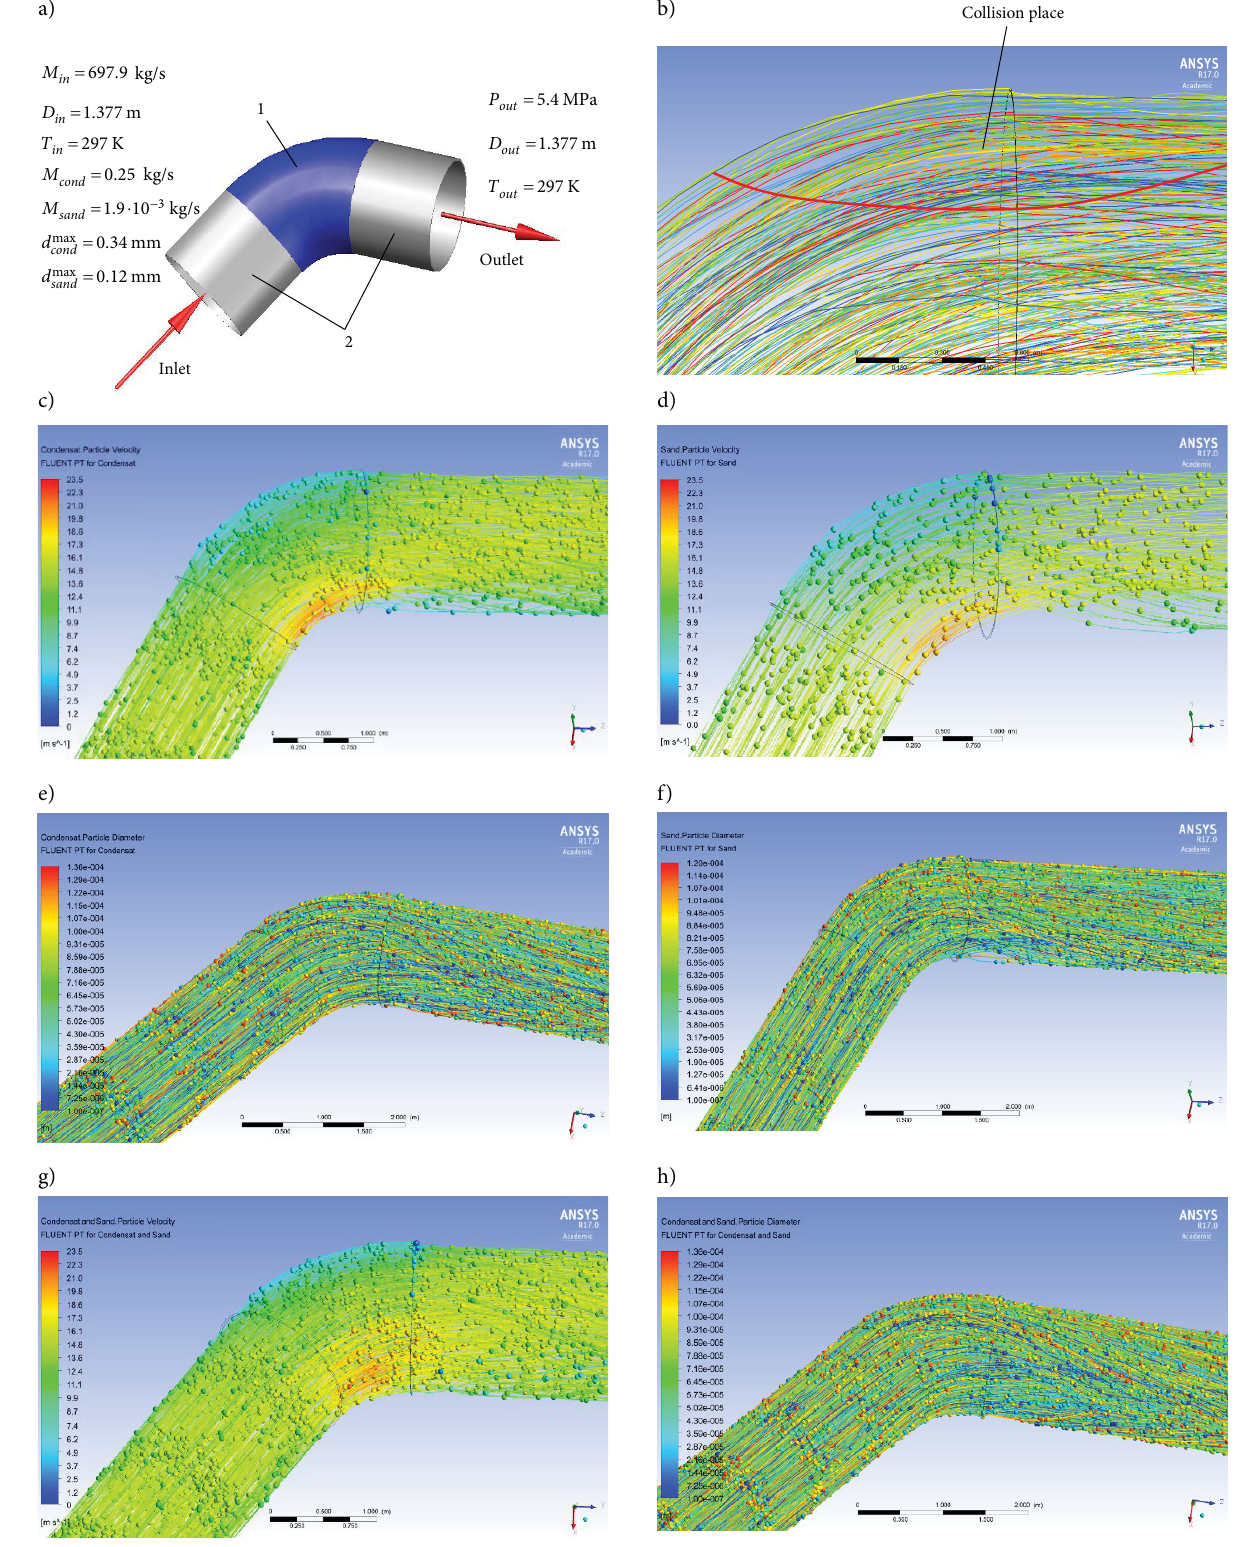
Figure 3. The results of modeling the discrete phase movement in the elbow of above-ground crossing: 1 – elbow 60 ° 1420 × 28 mm (Technical Specification GazTU 102-488/1-05); 2 – pipe 1420 × 21.5 mm; a – calculation scheme; b – trajectory of the discrete phase movement; c – trajectories of motion of condensed droplets painted in colors that match the velocity; d – trajectories of motion of solid particles painted in colors that match the velocity of particles; e – trajectories of motion of condensed droplets painted in colors that match the diameter of droplets; f – trajectories of motion of solid particles painted in colors that match the diameter of particles; g – trajectories of motion of condensed droplets and solid particles painted in colors that match the velocity; h – trajectories of motion of condensed droplets and solid particles painted in colors that match the the diameter of the droplets and